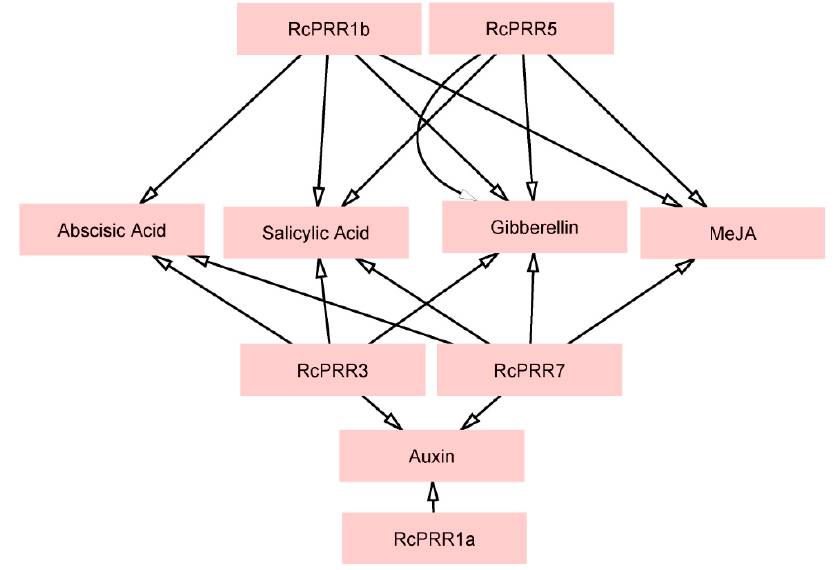
Figure 6. The interaction network of chemical compounds with clock PRRs . The network was performed by STRING and Cytoscape.